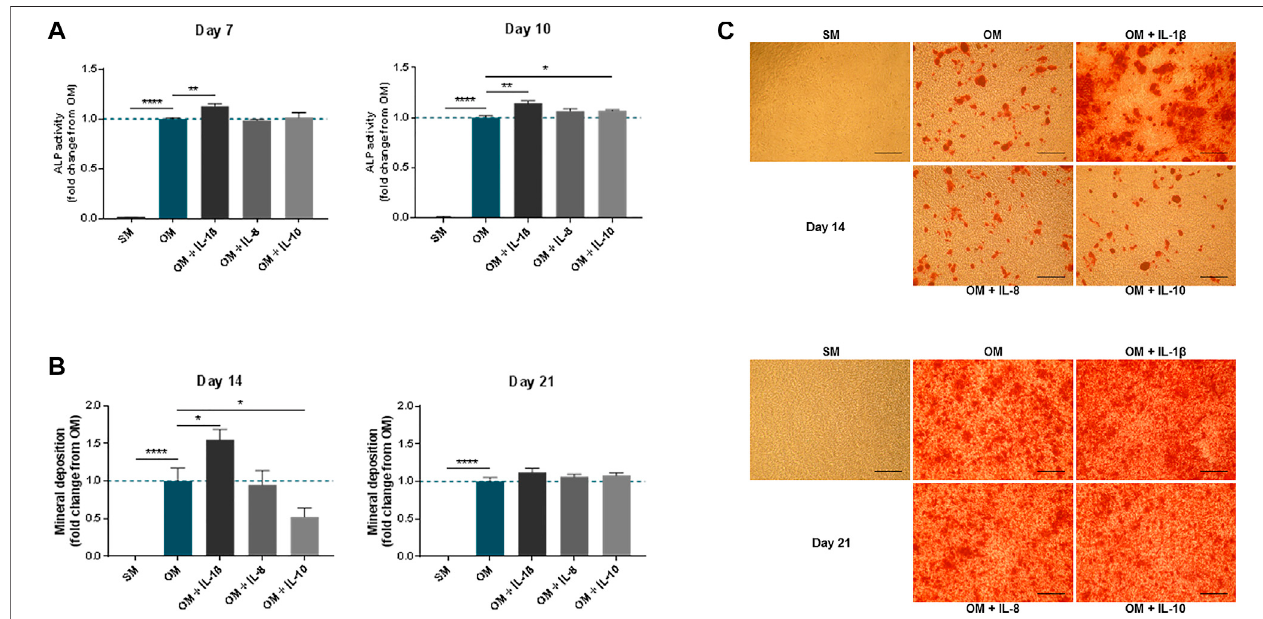
FIGURE 3 | Effects of IL-1 β , IL-8 or IL-10 supplementation on MSC osteogenic medium. ALP activity (A) and mineral deposition (B) measured in MSC cultures in the presence or absence of IL-1 β (100 pg/ml), IL-8 (2 ng/ml) or IL-10 (100 pg/ml) measured over up to 3 weeks. (C) Representative images of Alizarin Red staining at days 14 and 21. Scale bar = 150 μ m. Data shown as fold change compared to the OM control condition. Error bars represent SEM. n ≥ 4, * p < 0.05, ** p < 0.01, *** p < 0.001, **** p < 0.0001.